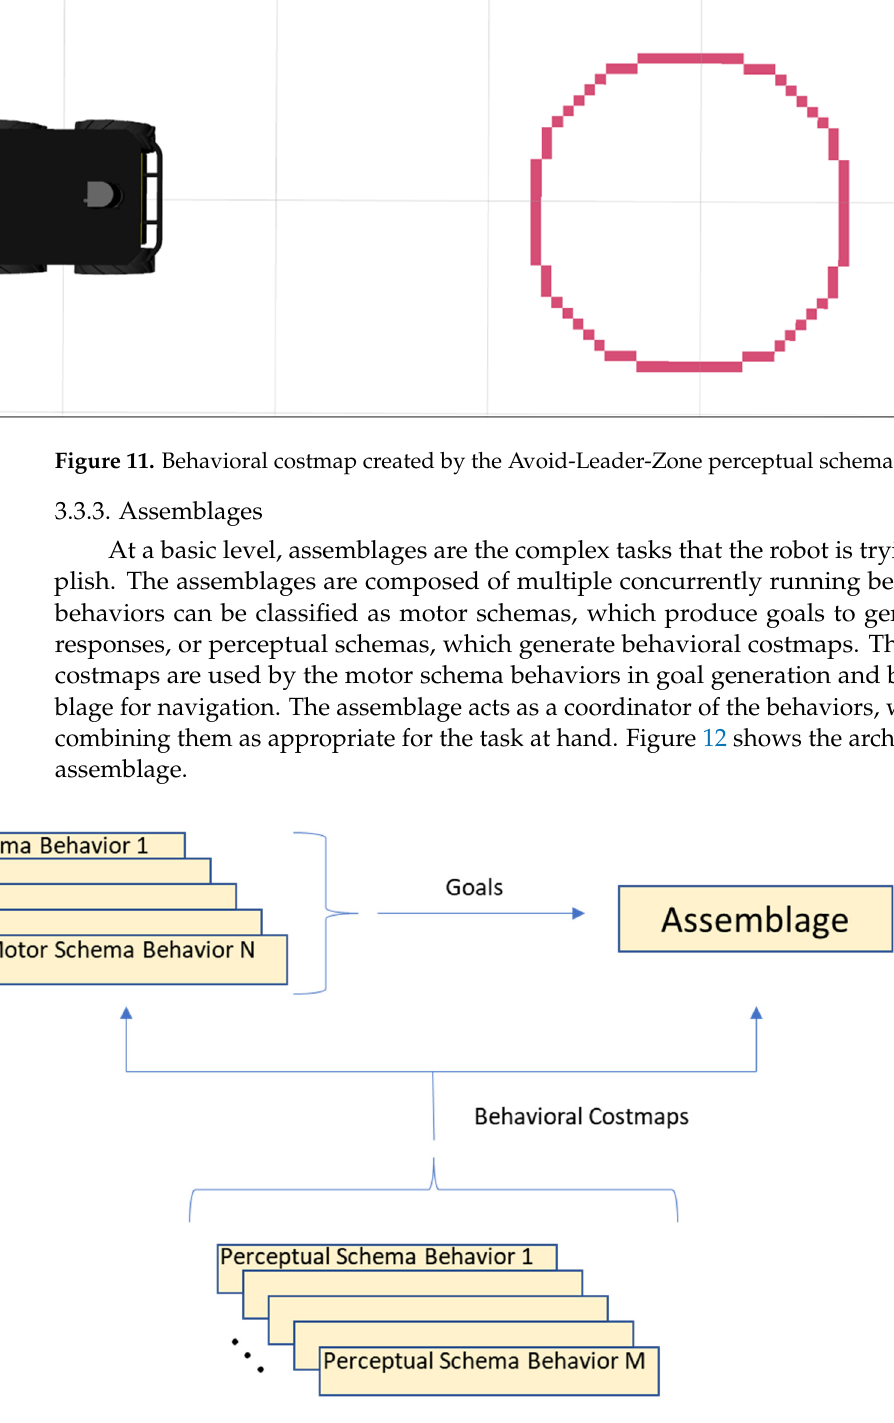
Figure 12. Architecture of an assemblage.